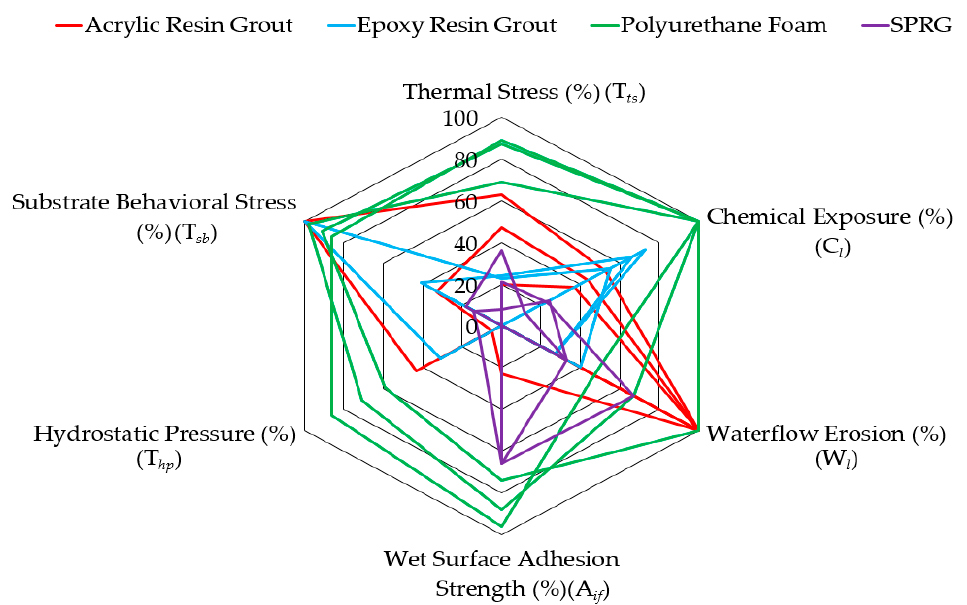
Figure 17. A comprehensive evaluation result of the four types of grout-injection materials.